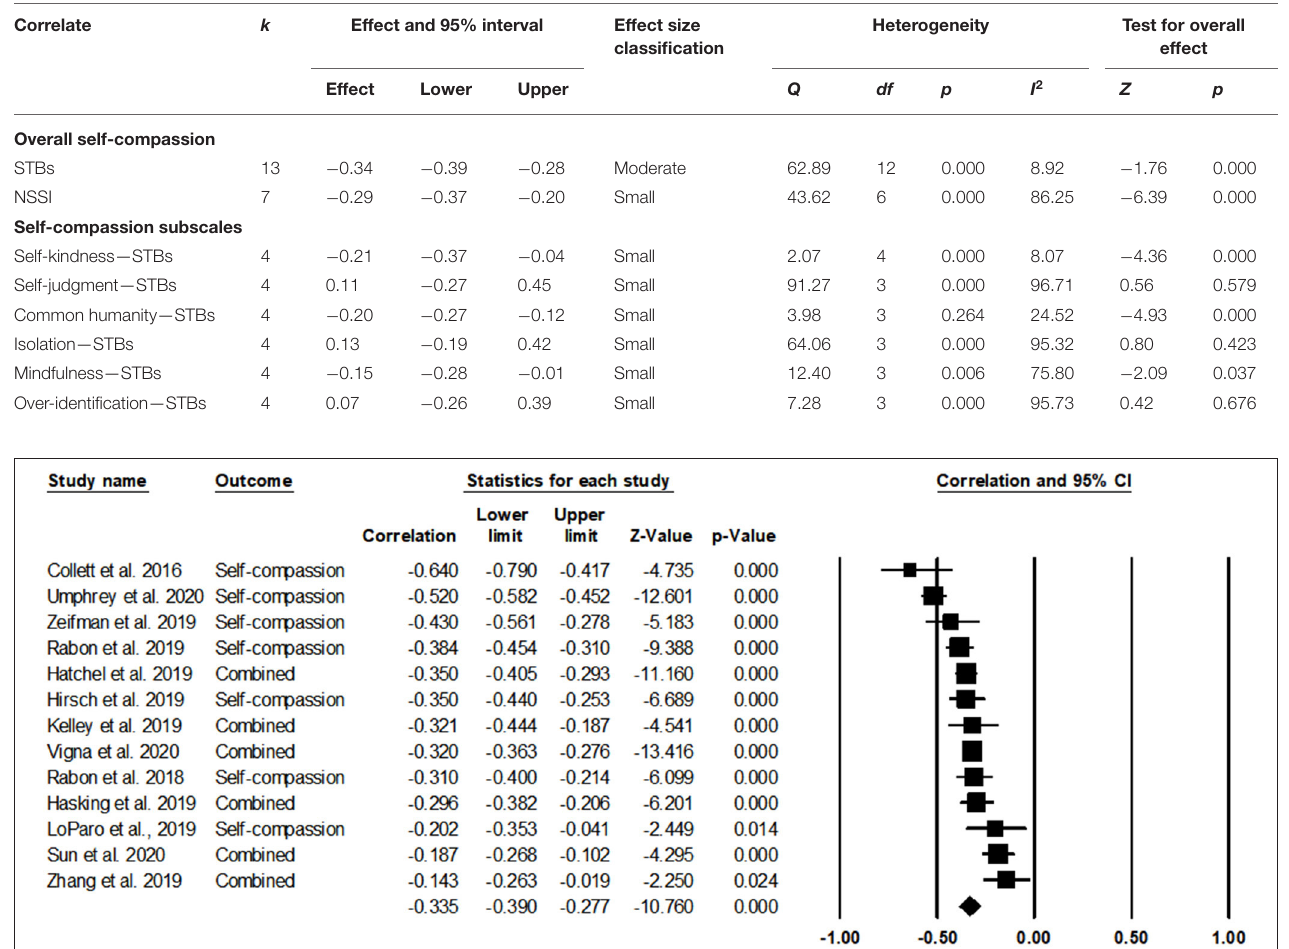
TABLE 3 | Effect sizes for composite and subscales of self-compassion. Correlate k